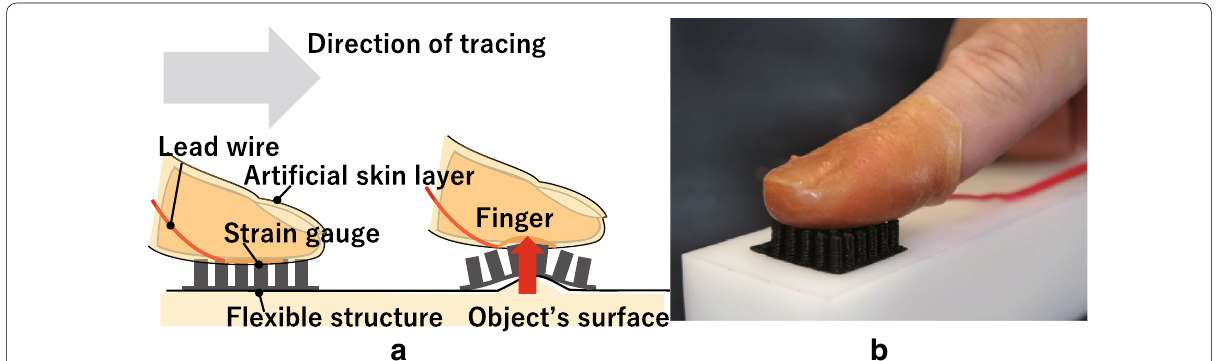
Fig. 1 Schematic diagram showing a the structure and b a photo of the proposed sensor. Deformation due to an undulation on the object’s surface is amplified by the pins of the flexible structure, after which information of the object’s surface is transmitted through the flexible structure to the sensor